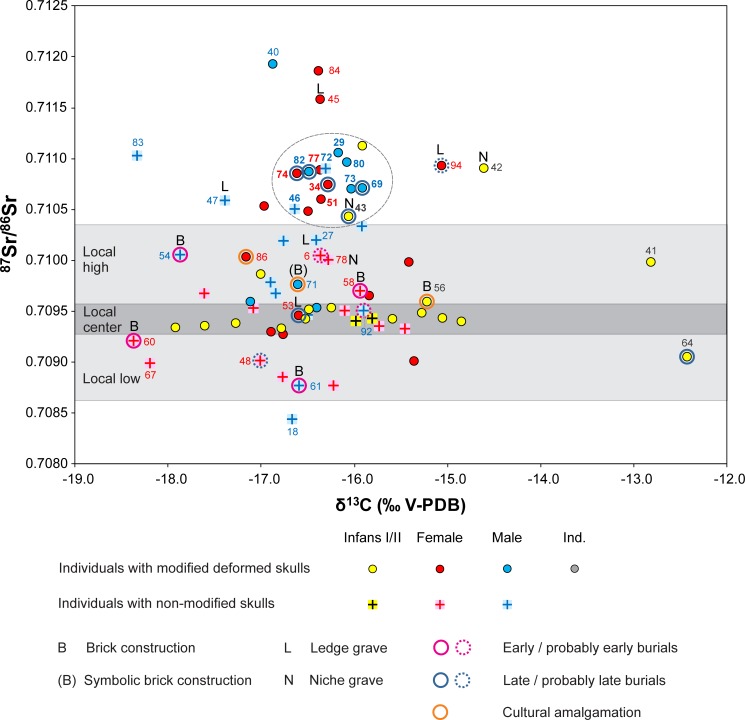
Scatter plot of δ13C values of bone collagen and 87Sr/86Sr ratios of enamel of the same individuals at the cemetery of Mözs.The grey ellipse highlights a tight cluster of individuals with highly similar Sr and C isotope ratios. Bold burial numbers indicate individuals who exhibit also very similar δ15N values.